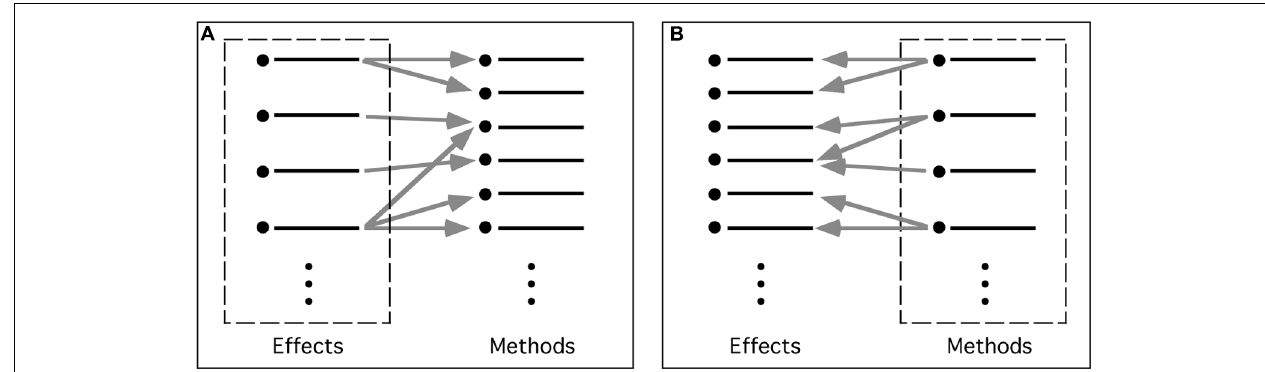
FIGURE 2 | Inventories centered on different aspects of magic tricks. (A) Effect-centered inventory. Here, effects are primary, with each effect—or component—linked to the various methods able to create it. (B) Method-centered inventory. Here, each method—or component—is primary, and is linked to the set of effects that it helps